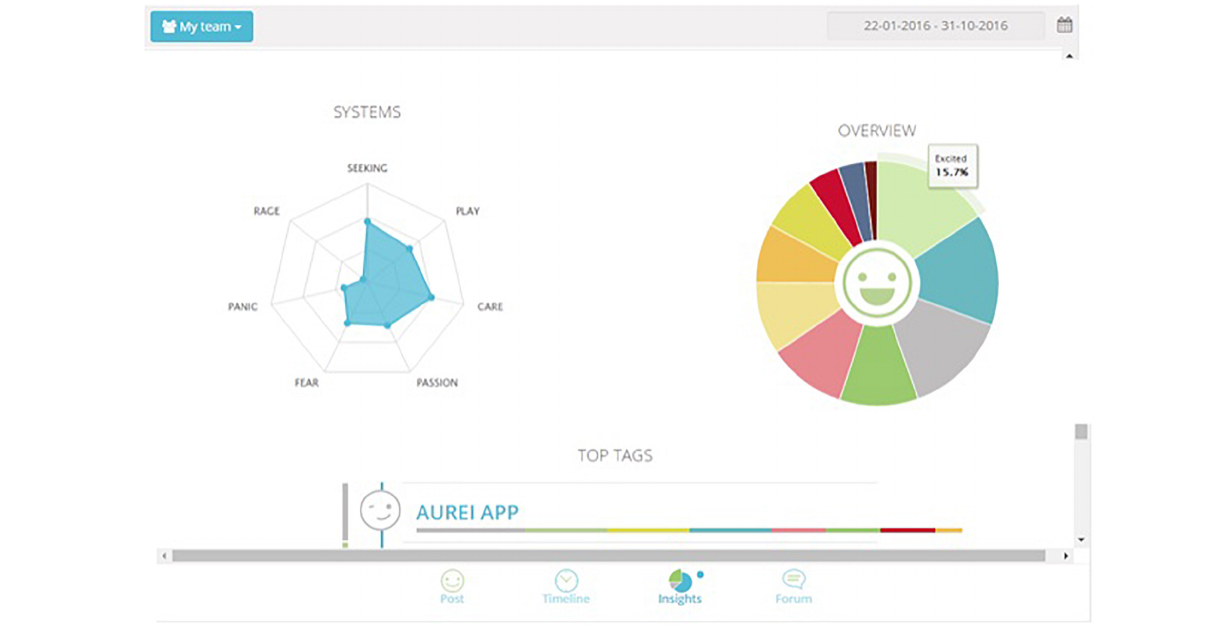
Frontiers in Psychology |